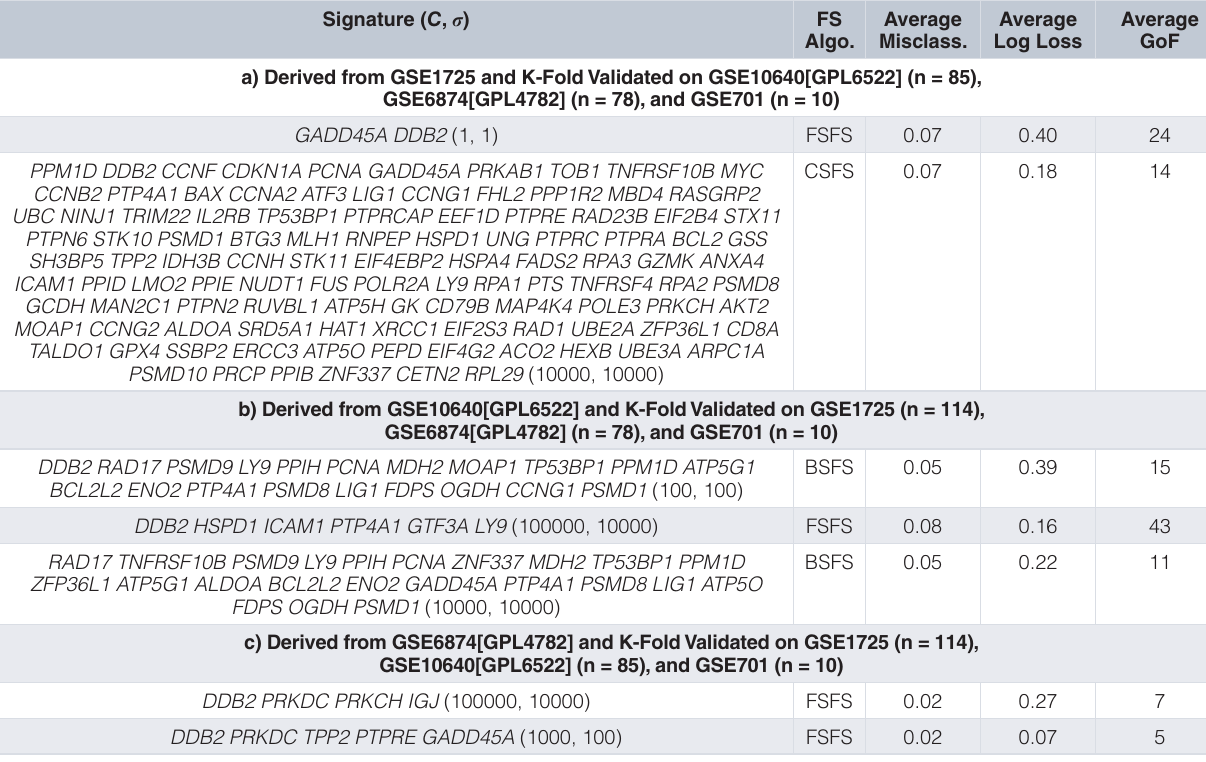
Table 2. Best human signatures assessed by K-Fold